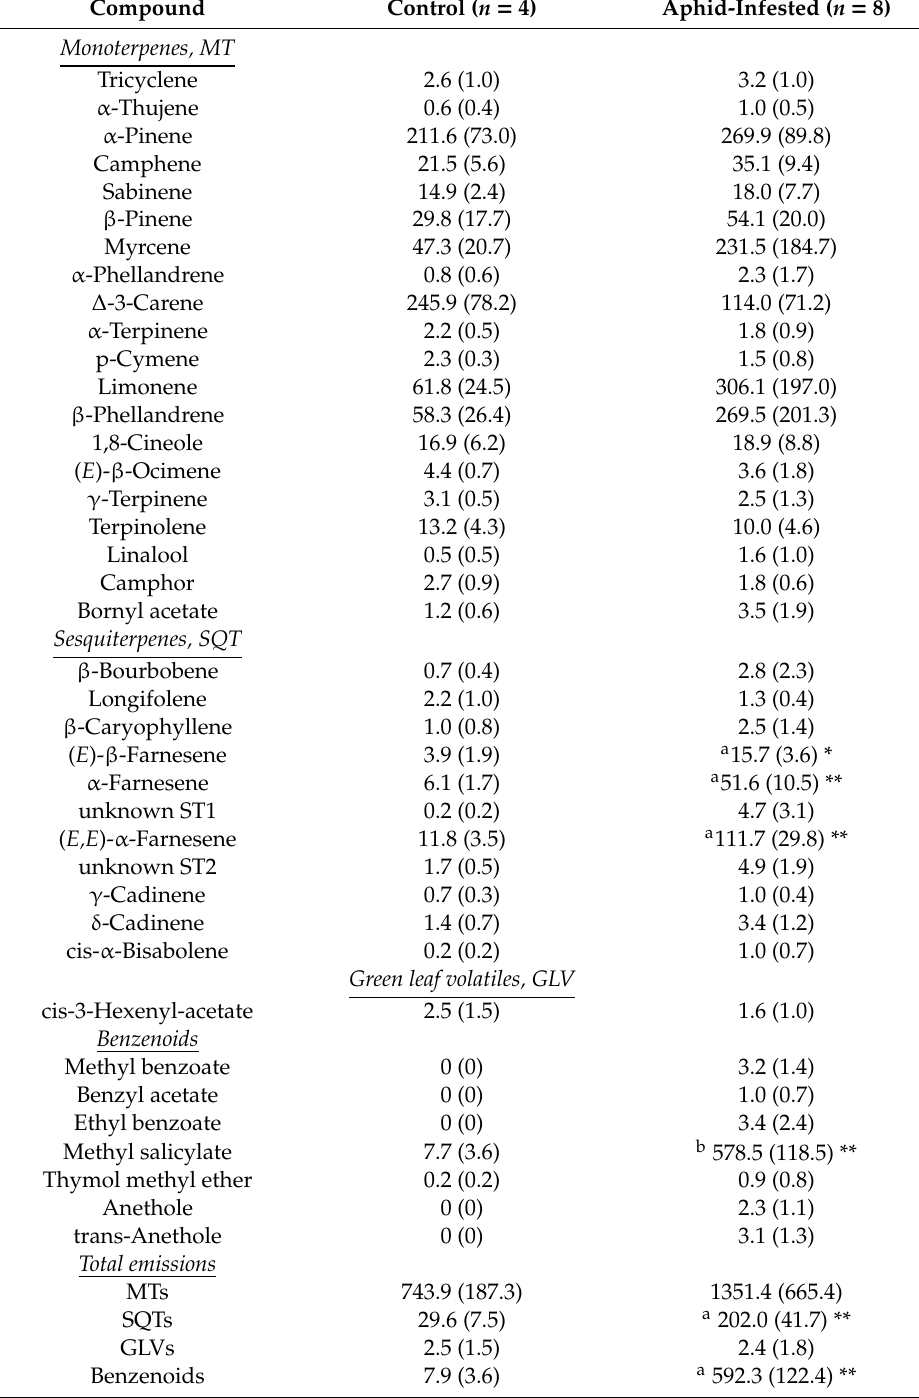
Table 1. Mean (SE) biogenic volatile organic compounds (BVOC) emission rates (ng cm − 1 shoot length h − 1 ) of uninfested and aphid-infested Scots pine branches 5 weeks after aphid infestation in 2016 (Experiment 2). Emboldened values indicate significant (* P < 0.05, ** P < 0.01, a t-test or b Mann–Whitney test) di ff erences between the